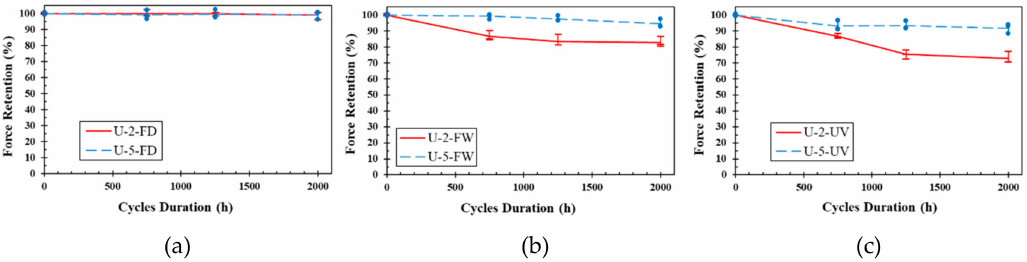
Figure 9. Retention ultimate tensile strength vs. exposure period of UL: ( a ) Dry freeze / thaw cycles, ( b ) wet freeze / thaw cycles and ( c ) UV and water vapor condensation cycles.